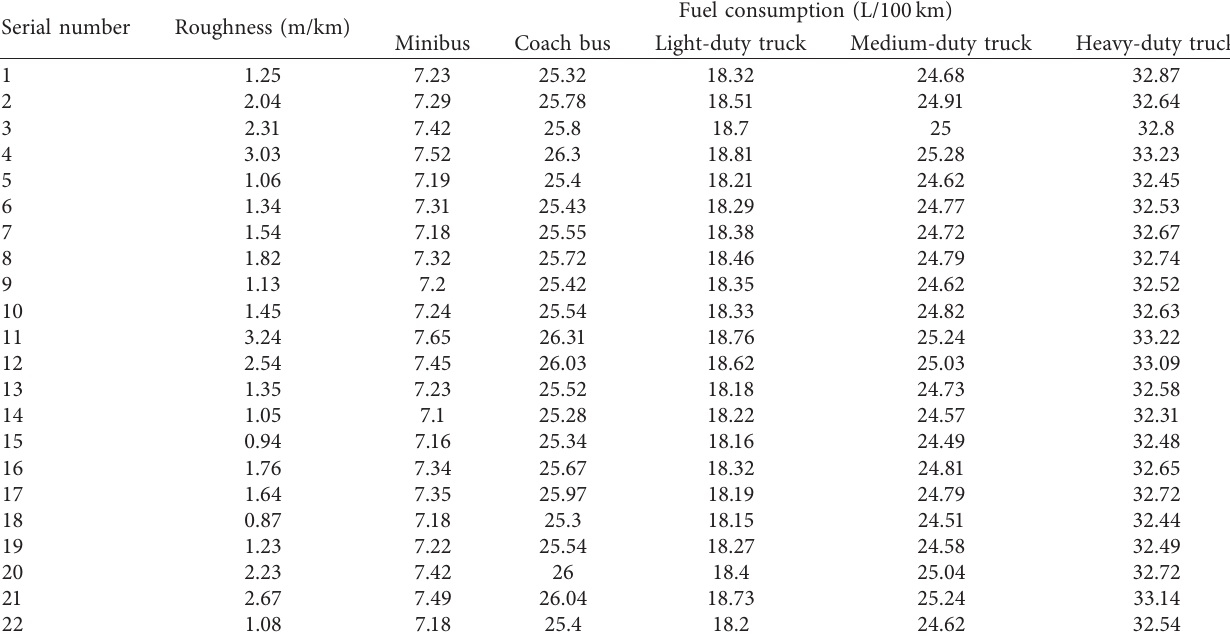
Table 4: Partial sample data: fuel consumption